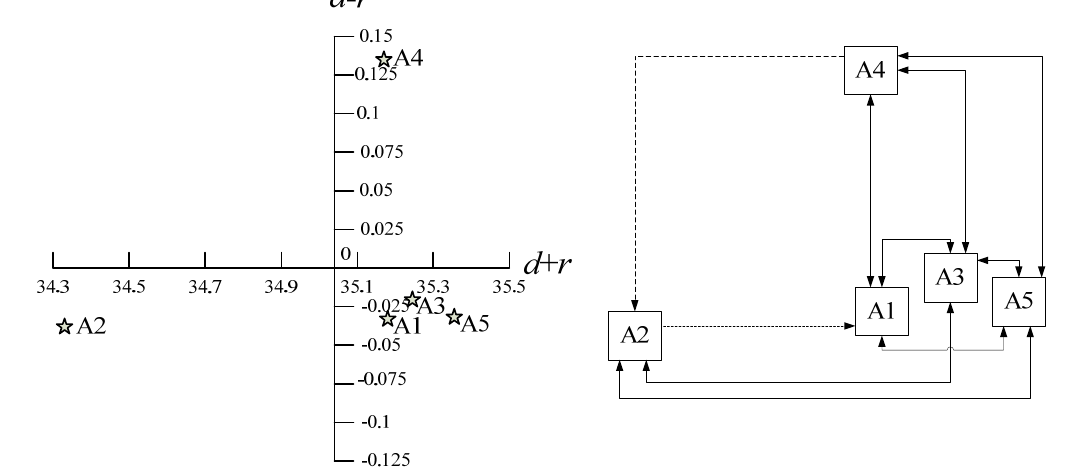
Figure 2. Cause–e ff ect diagram and influence–relation Figure 2. Cause–effect diagram and influence–relation map.